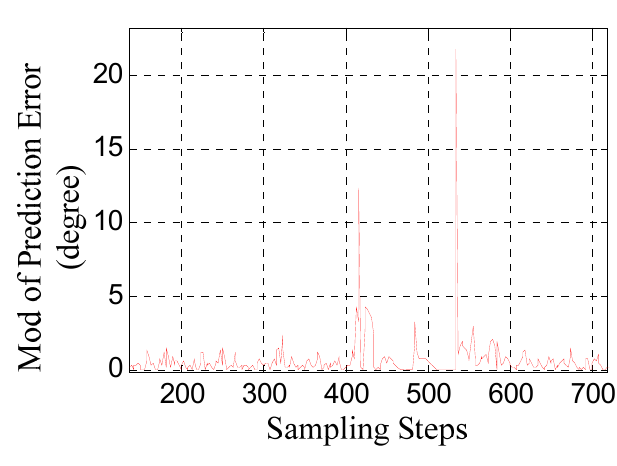
Figure 10. The prediction